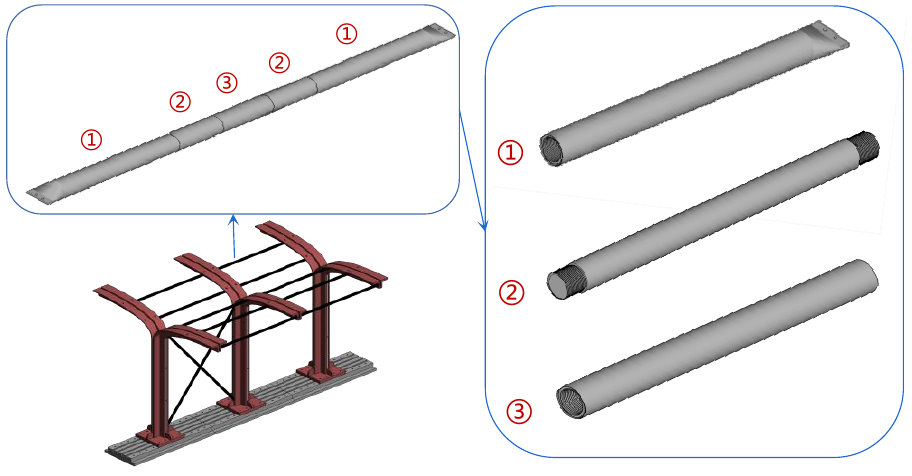
Figure 15 Prefabricated connecting rods. Figure 15. Prefabricated connecting rods.